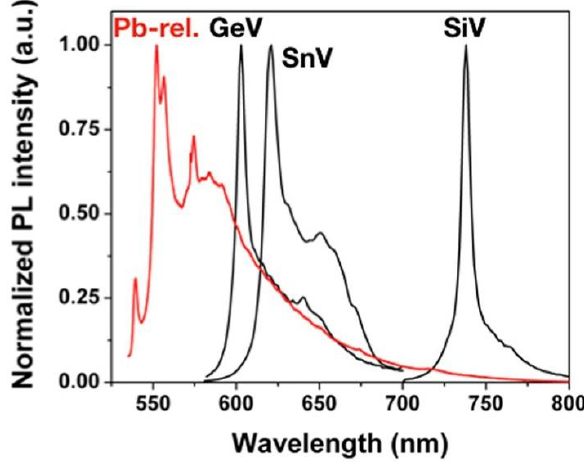
Figure 19. Fluorescence spectra of color centers in diamonds under 532 nm laser excitation. Lead-related (Pb-rel), germanium-vacancy (GeV), tin-vacancy (SnV), and silicon-vacancy (SiV). Reproduced with permission from [113], Springer, 2013.